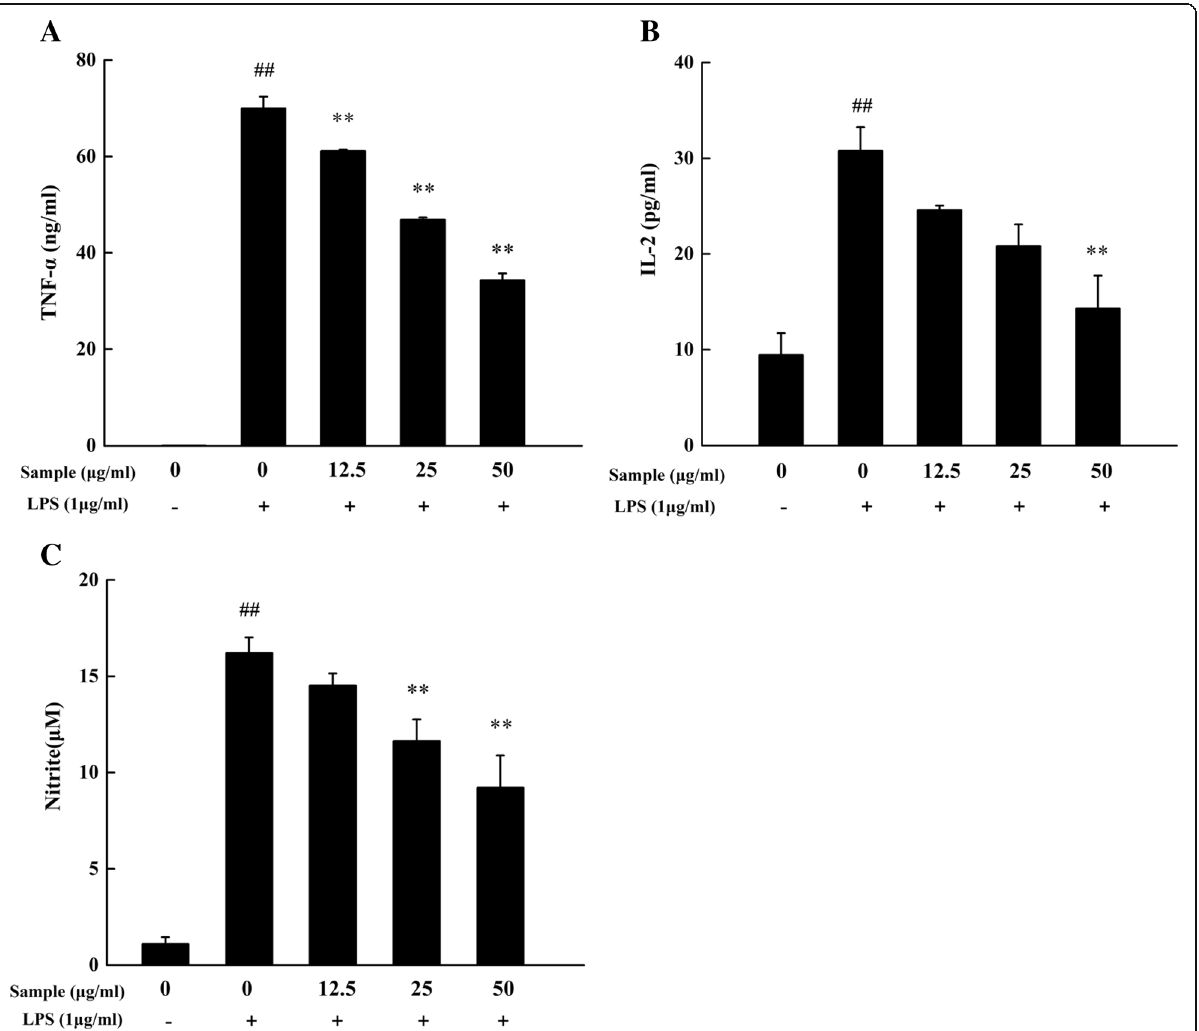
Fig. 3 Effect of YYHs on TNF- α ( a ), IL-2 ( b ) and NO ( c ) production in LPS-induced RAW 264.7 cells. Cells were pretreated with YYHs (12.5 – 50 μ g/mL) and LPS for 24 h and collected culture supernatant. The culture supernatant was detected to ELISA kits and Griess reagent, respectively. Compared with the control, # P <0.05, ## P <0.01. Compared with LPS group, * P <0.05, ** P